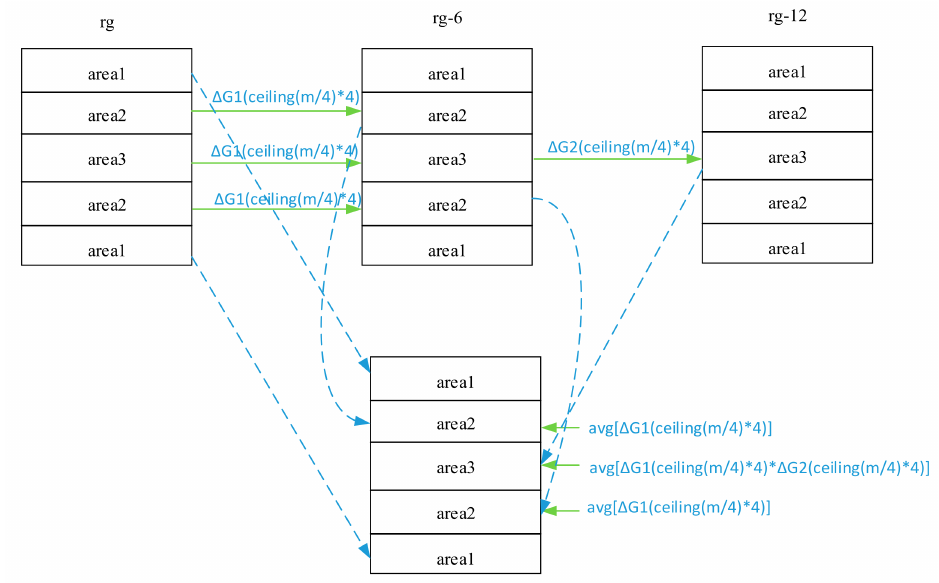
Figure 2. k-space data splicing and gain